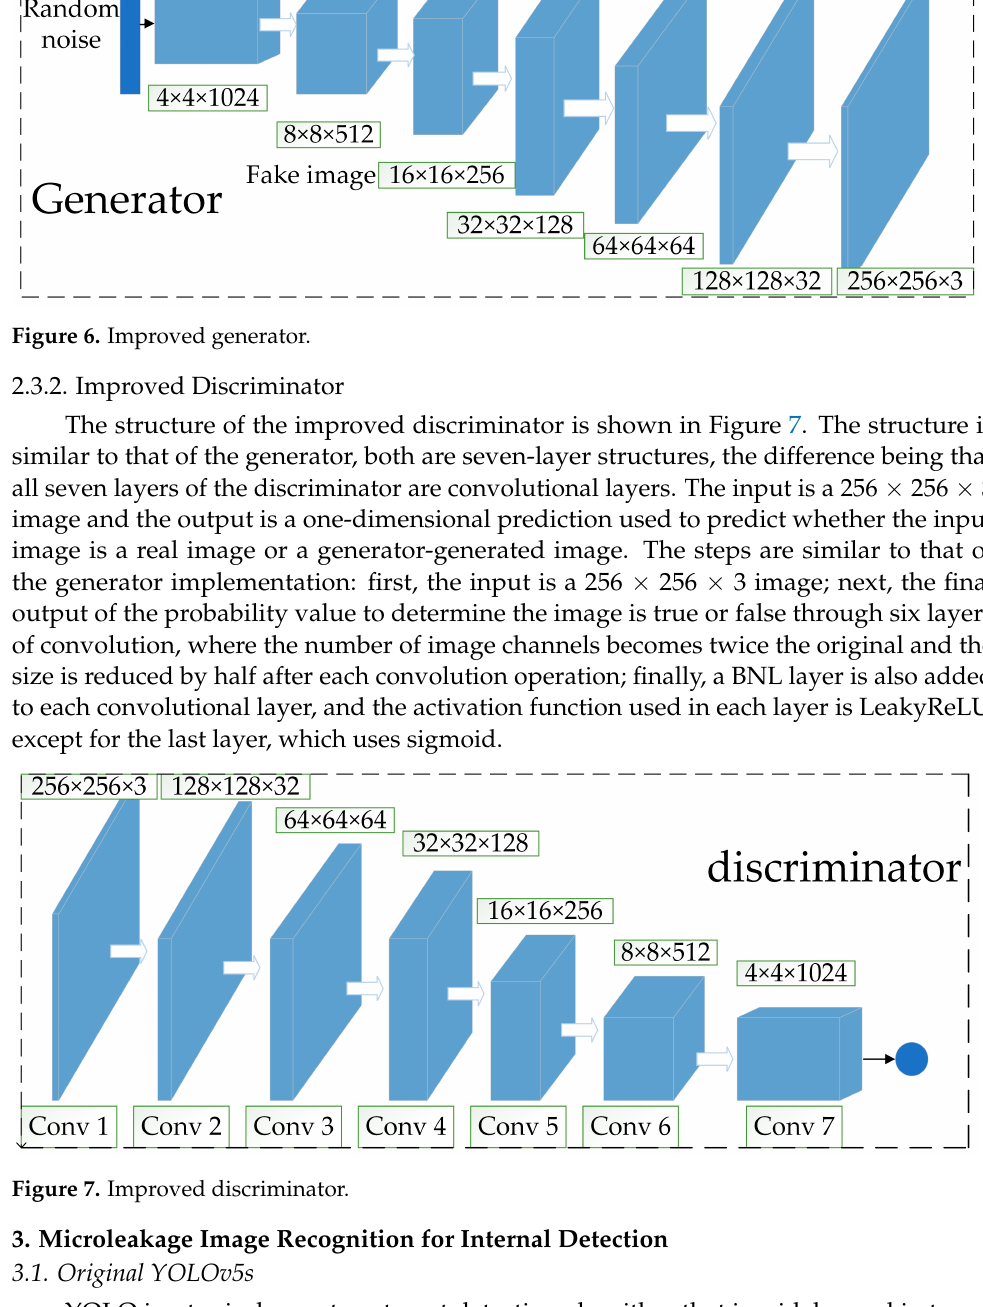
Figure 8. The overall architecture of the original YOLOv5s network. The YOLOv5s network has a complex structure and can be made up of a variety of modules. The most basic modules of YOLOv5s include: CBL, Res unit, CSP 1_X, CSP 2_X, Focus, SPP, etc. The backbone is mainly used to extract features of di ff erent scales of the target. Among them, the Focus module slices the input image, doubles the image size and changes the number of feature maps to four times the original size, and then stacks the